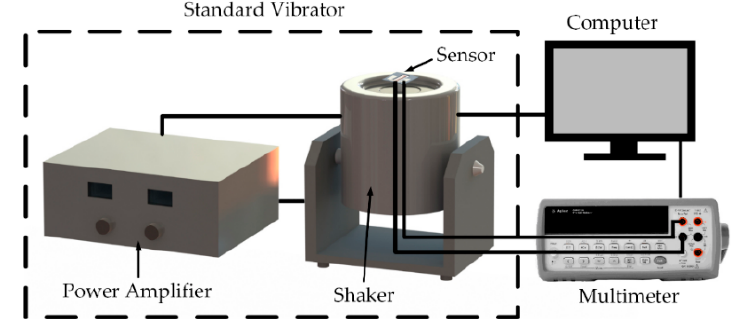
Figure 10. Piezoelectric characteristic of pure ZnO and 5 wt % LZO.